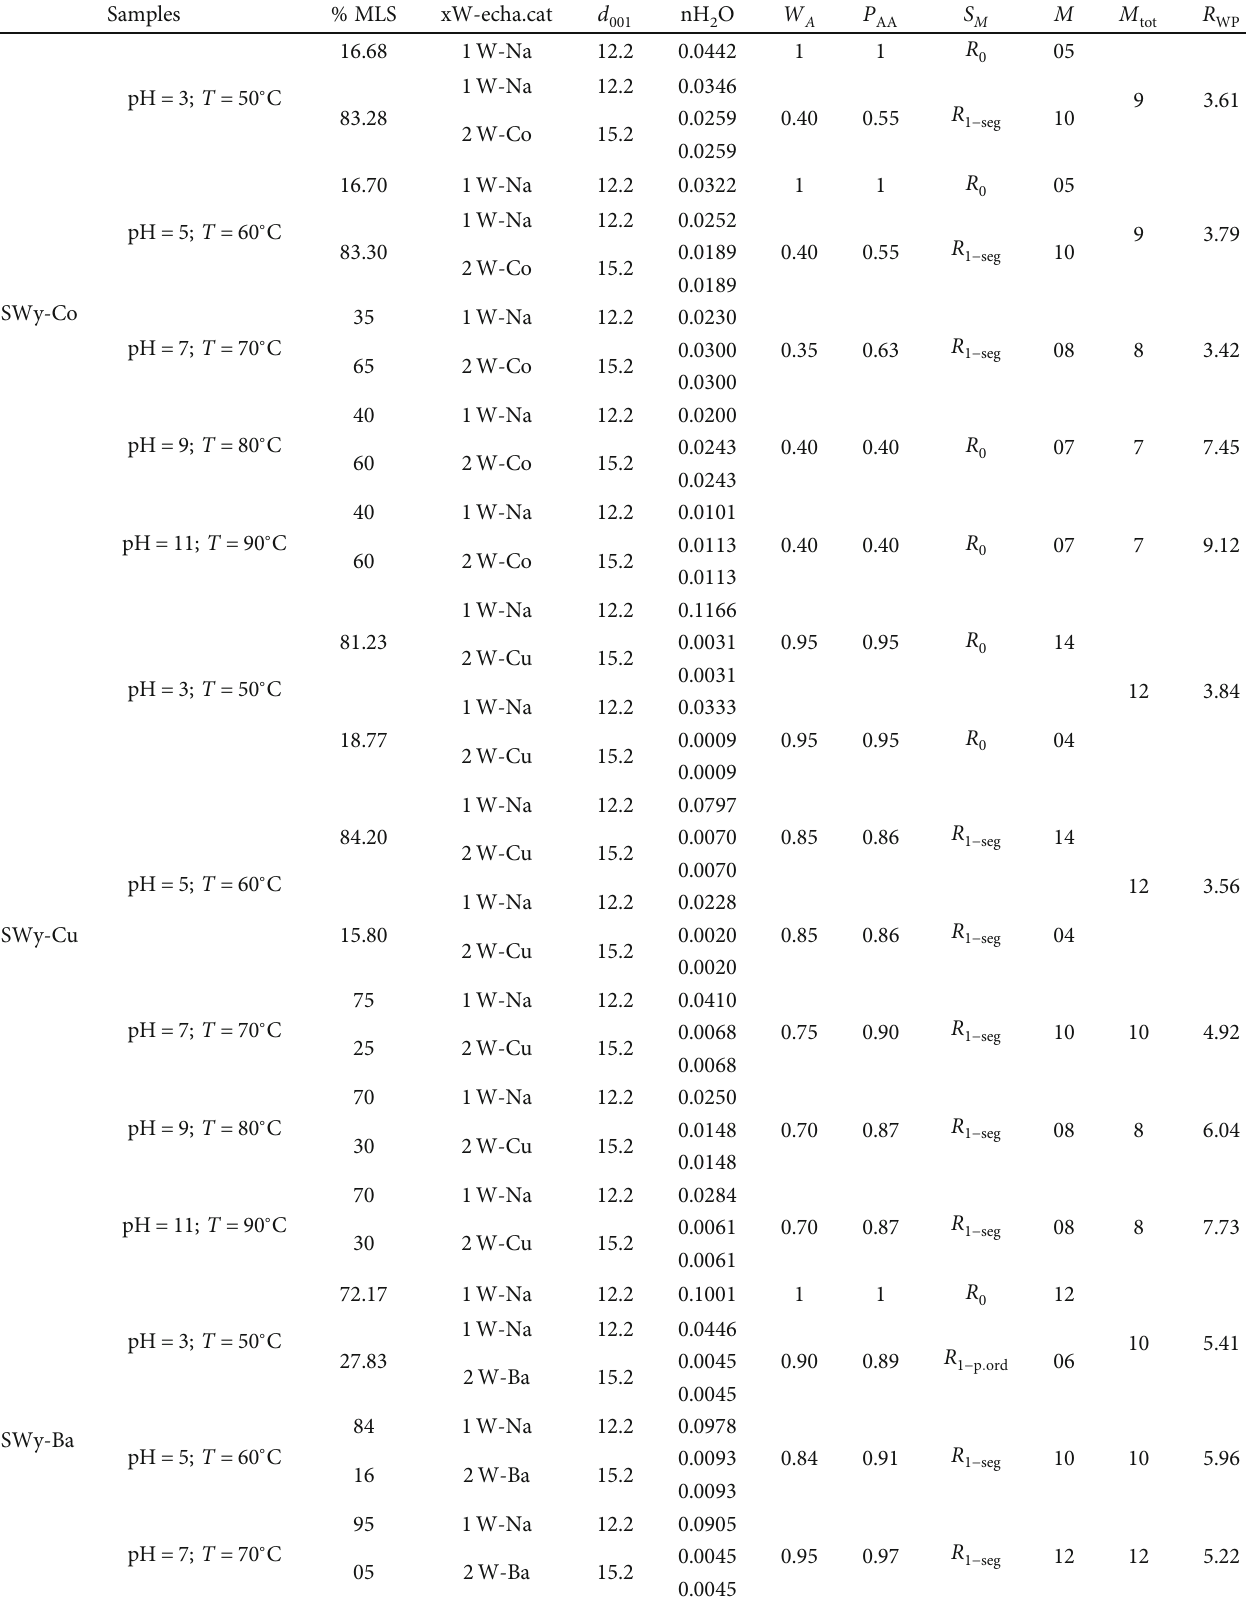
Table 7: Structural parameters of SWy-Co, SWy-Cu, and